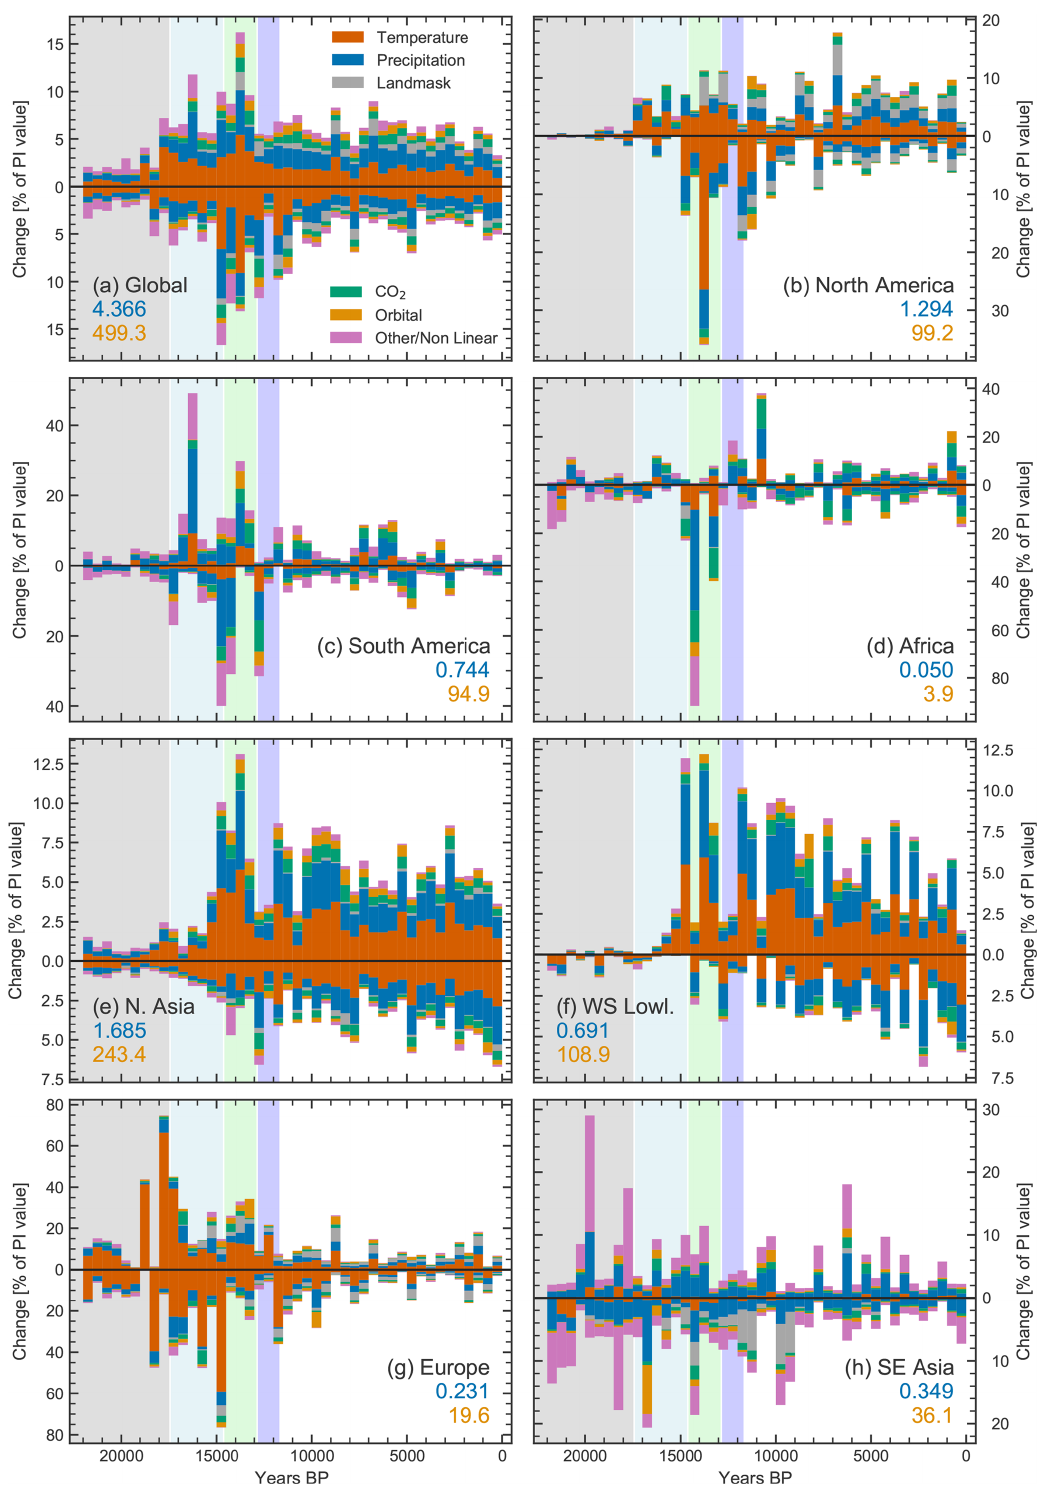
Figure A2. Simulated global and regional gross positive and negative changes in peatland area in 0.5kyr bins, relative to PI levels. PI levels are given in millions of square kilometers (Mkm 2 ) for peat area and in gigatons of carbon (GtC) for peat carbon. Colors indicate driver contributions to changes attributed using factorial simulations. The extent of the northern Asia, western Siberian (WS) lowland, and Southeast Asia regions are shown in Fig. 1. The background colors indicate different time periods, as in Fig.